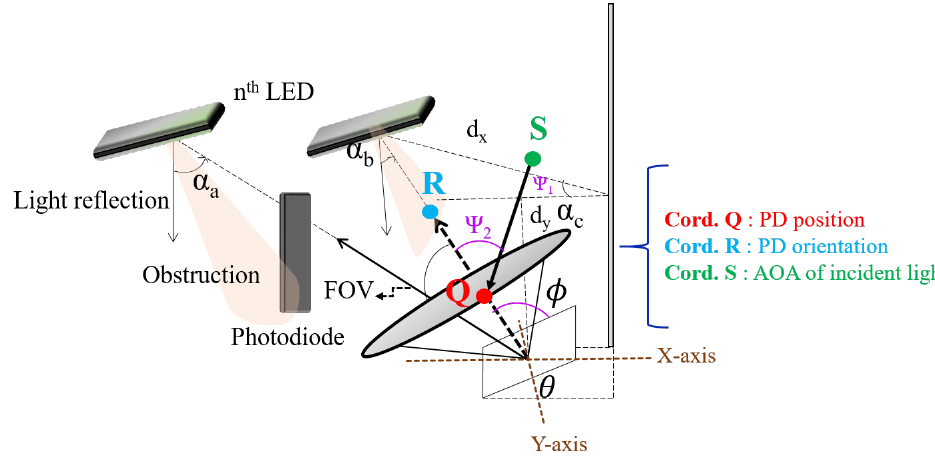
Figure 6. Graphical representation of the proposed receiver